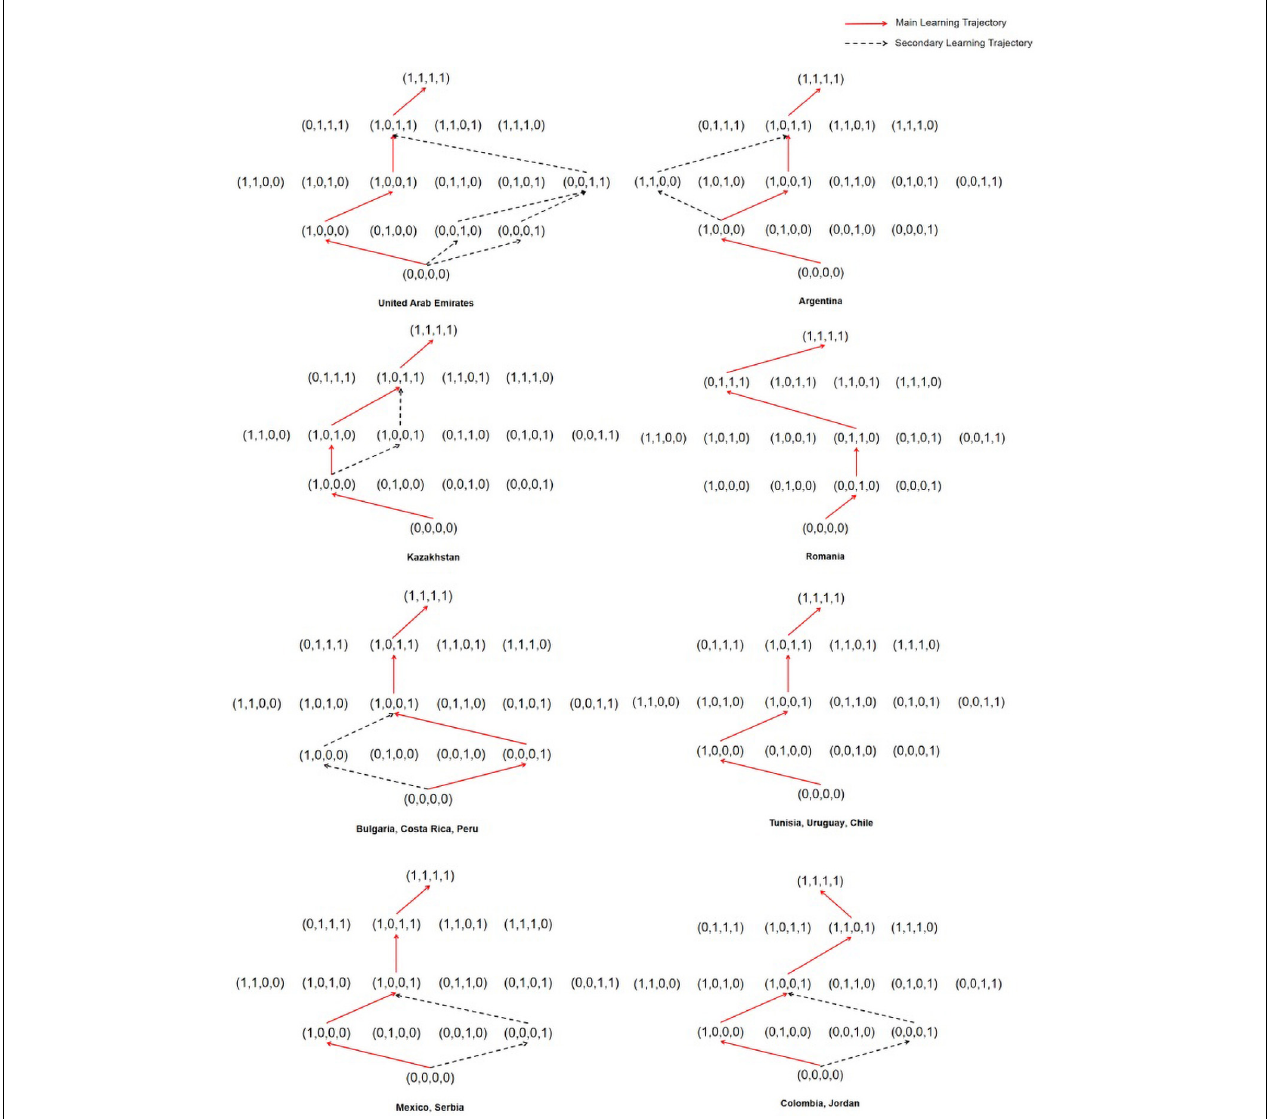
FIGURE 2 | Figures of learning